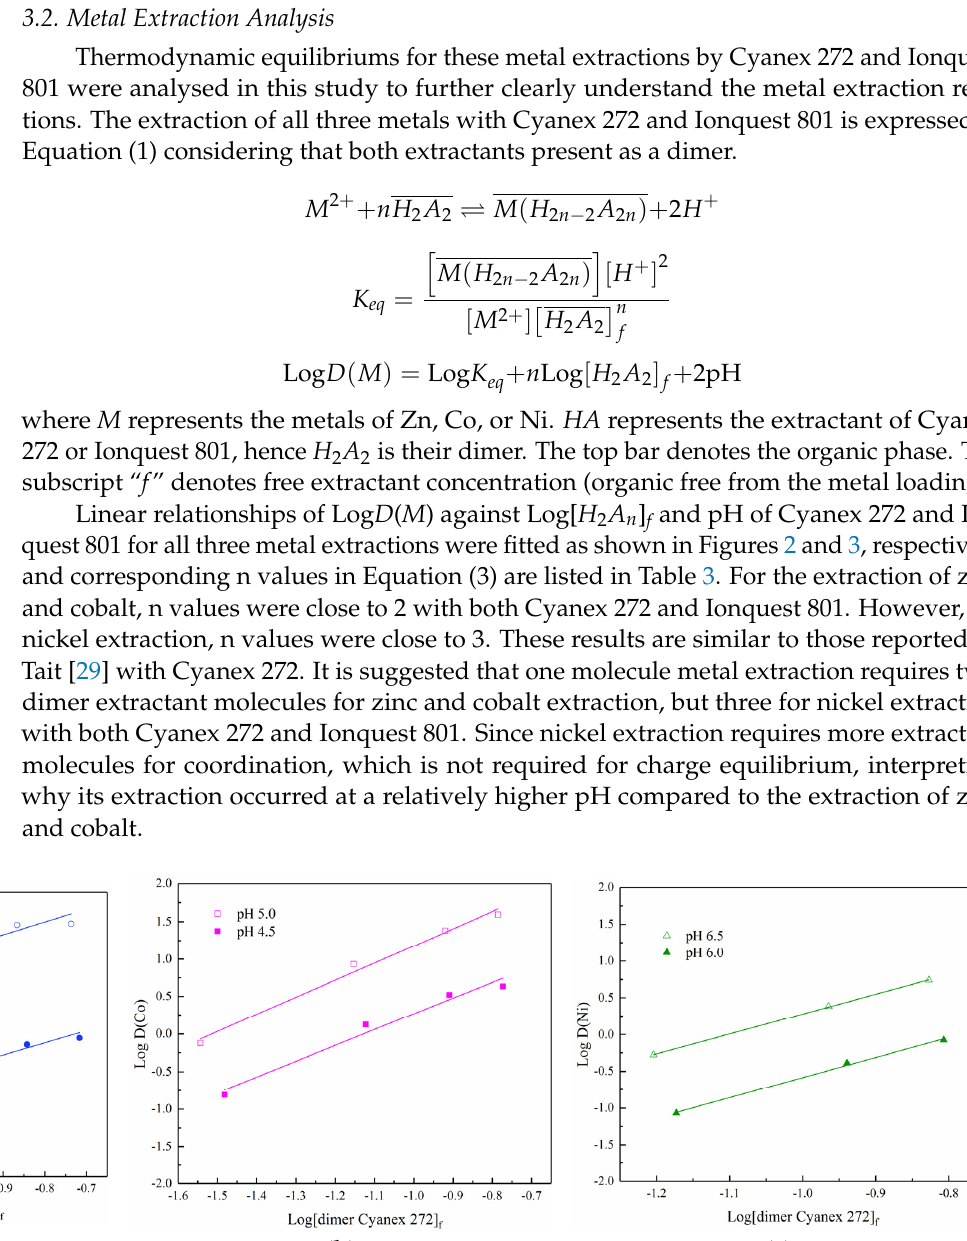
Figure 3. The relationship of Log D ( M ) against Log [dimer Ionquest 801] f . ( a ) Log D(Zn)-Log[dimer Ionquest 801], ( b ) Log D(Zn)-Log[dimer Ionquest 801], ( c ) Log D(Zn)-Log[dimer Ionquest 801].